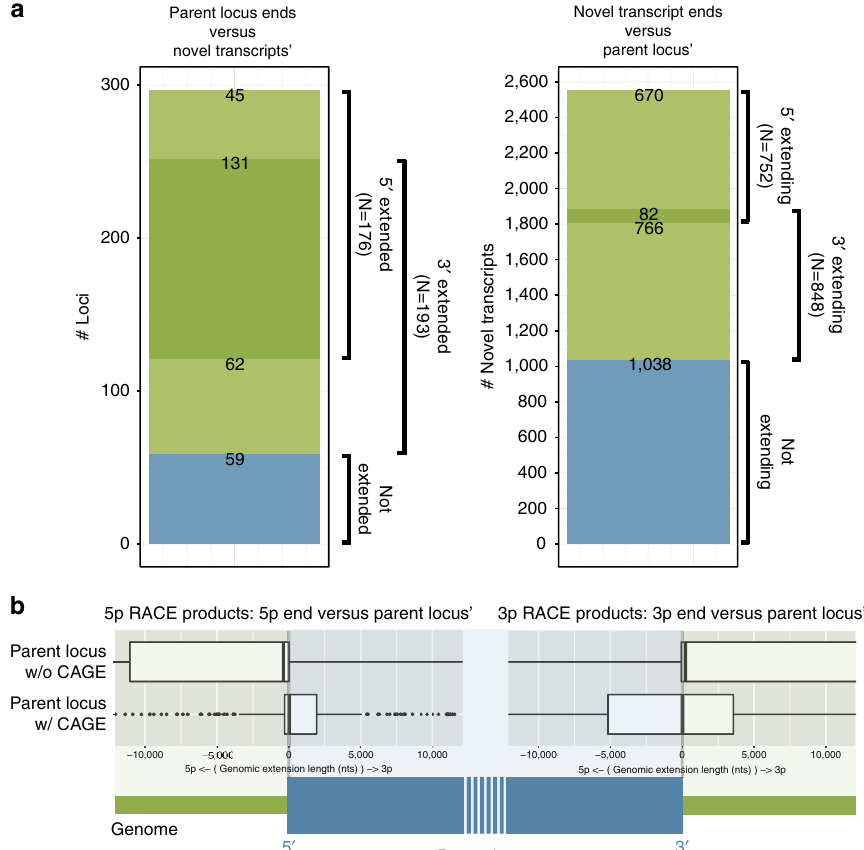
Figure 2 | Locus extension and novel transcript boundaries. ( a ) Venn diagrams depicting the proportion of loci (left panel) and transcripts (right panel) extended in 5 0 and/or 3 0 direction. ( b ) Novel boundaries for CAGE-supported (bottom box-plot) and CAGE-unsupported loci (top box-plot). A schematic depiction of a target locus is provided below the plots. The viewing range of the box plots is reduced ( (cid:2) 10,000, 10,000 nucleotides) for values represent novel transcription start sites (TSSs) upstream of the annotated locus), respectively, for CAGE-supported and unsupported loci (Fig. 2b, and example in Fig. 5b). Surprisingly, we observed a similar phenomenon at the 3 0 end of targeted loci: the mean/median genomic length of 3 0 extensions amounted to (cid:2) 15/ (cid:2) 526 and þ 225/ þ 8,518 (positive values correspond to